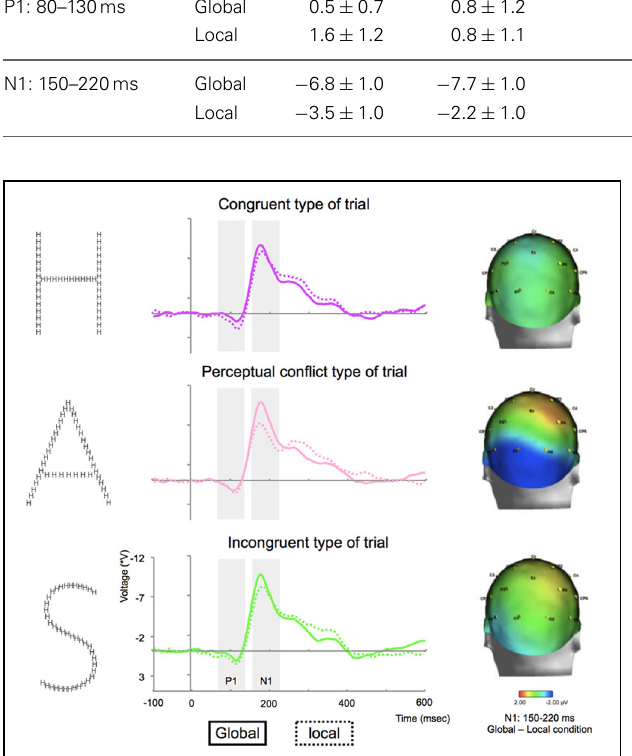
FIGURE 4 | Grand average ERP waveforms for congruent (top), with perceptual conflict (middle) and incongruent stimuli (bottom) on P7 electrodes and differences between the N1 component elicited by global and local tasks for congruent, with perceptual conflict and incongruent stimuli projected on a 3D scalp from a posterior head